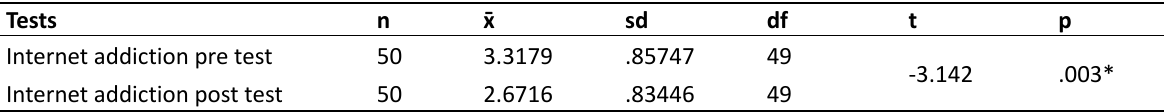
Table 3. Evaluation of the internet addiction pre and post the participation of regular exercise